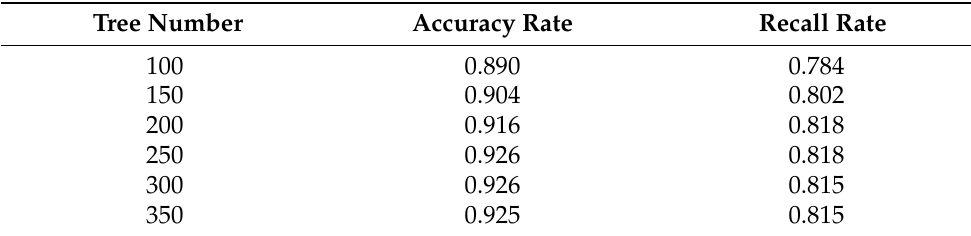
Table 2. The relationship between the number of decision trees and the performance of ran- dom forests.